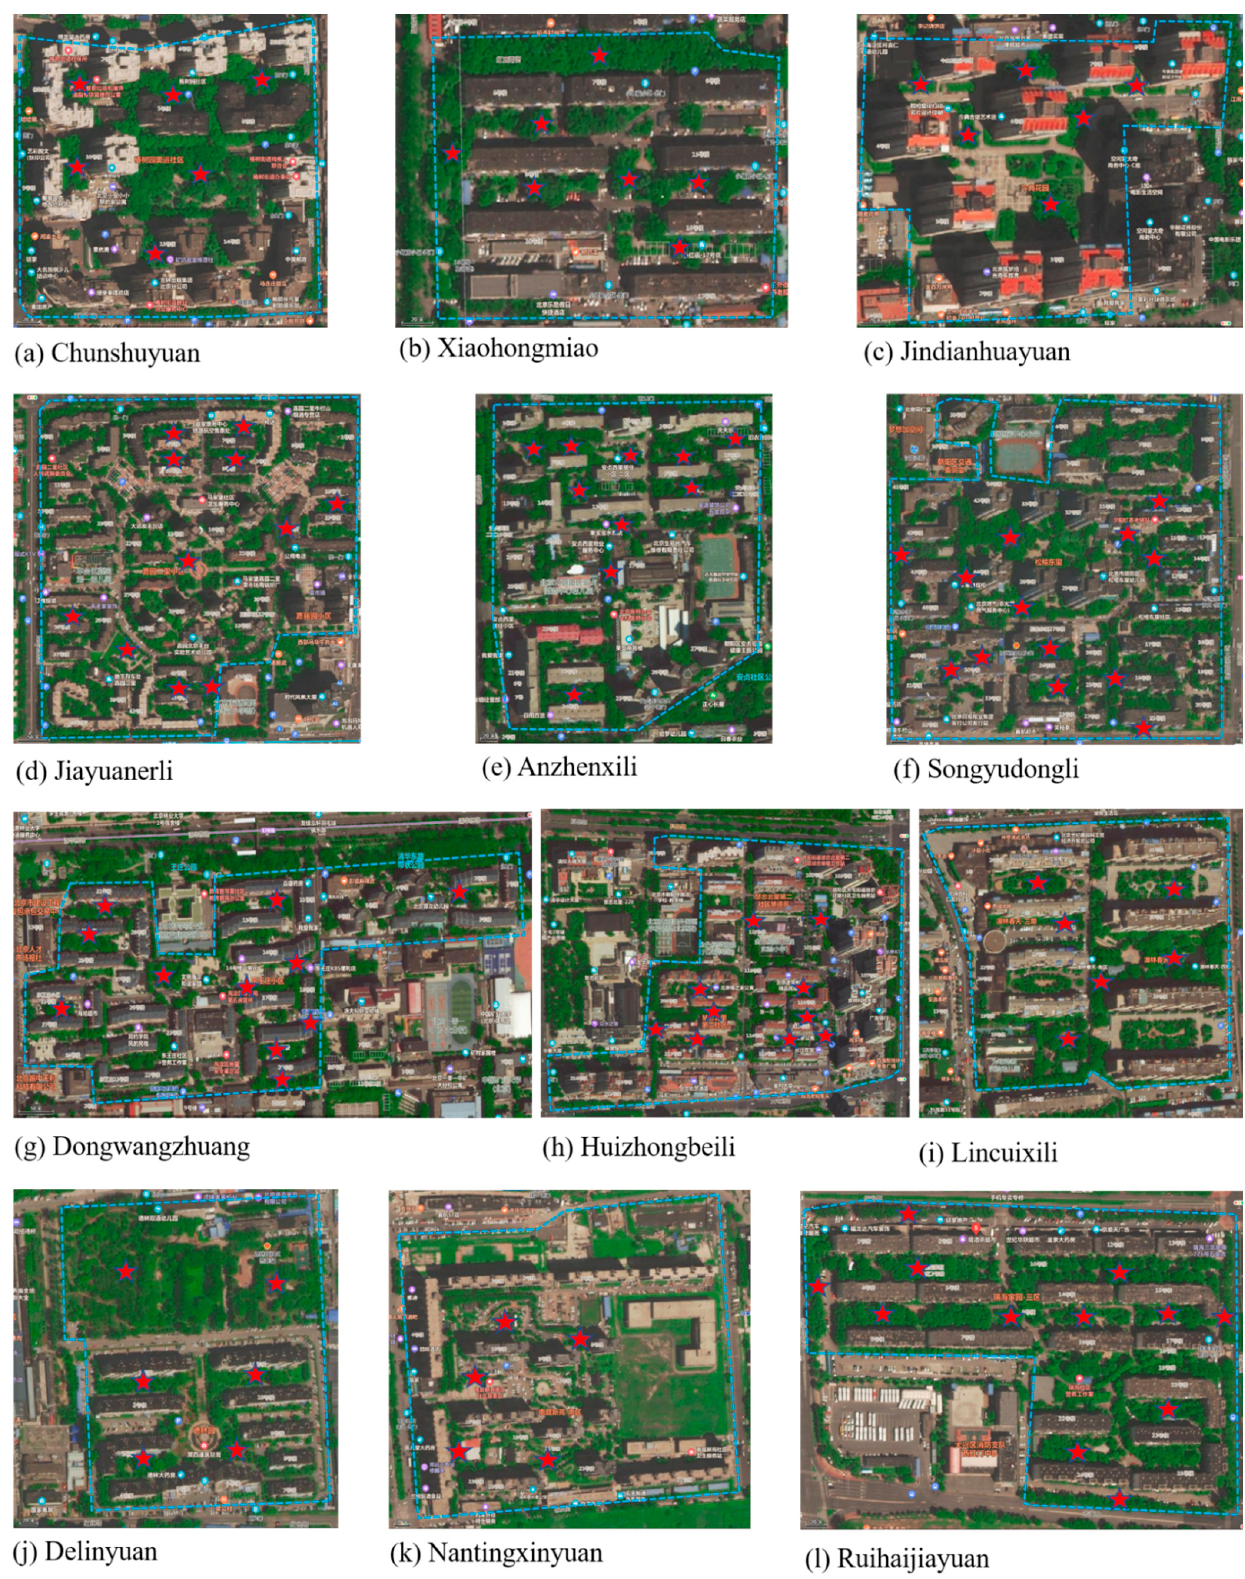
Figure A1. The location of patches investigated in each neighborhood. The red stars indicate the location of patches. The dotted blue lines indicate the boundaries of the neighborhoods.